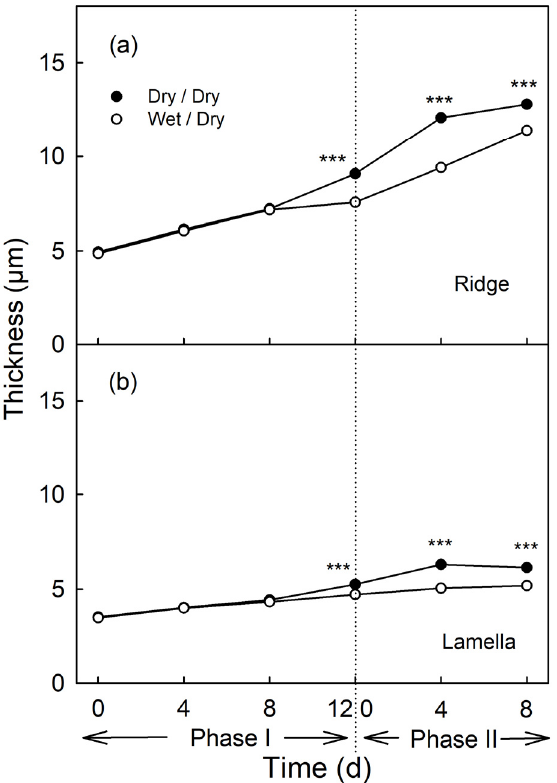
Figure 8. E ff ect of moisture exposure on the thickness of the cuticle above the anticlinal cell walls (ridge) ( a ) and above the periclinal cell walls (lamella) ( b ) of the apple fruit skin. In Phase I, the fruit was exposed to moisture for 12 d. Phase II began following termination of moisture exposure (indicated by the dotted vertical line) and the surface remained dry thereafter (wet / dry). Fruit surface without moisture exposure served as control (dry / dry). *** indicate significant di ff erence between ‘dry / dry’ and ‘wet / dry’ treatment at p < 0.001. Data represent means ± SE ( n = 6) .